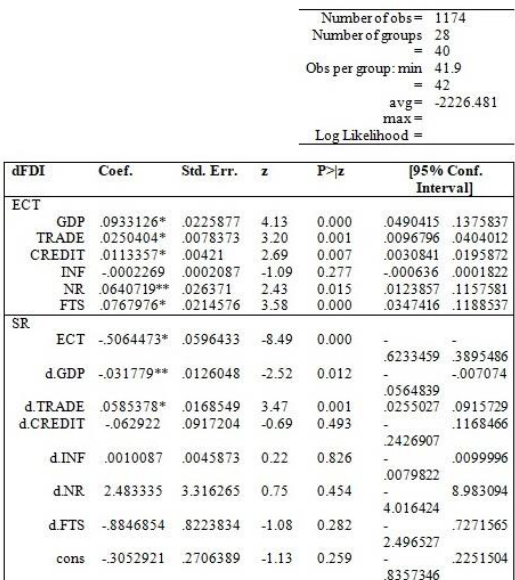
Table 8 covers the coefficient values,